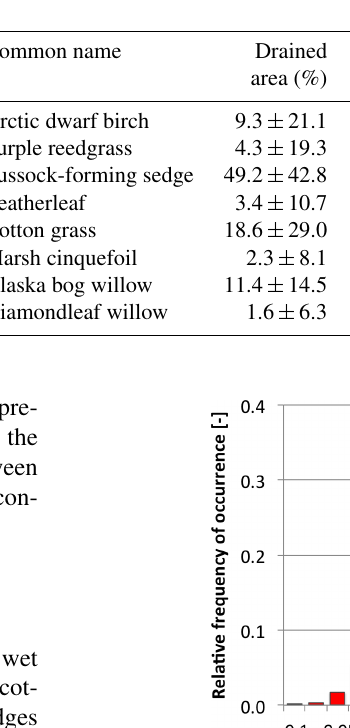
Table 1. Relative abundance of the major vascular plant species found within both disturbance regimes in the context of a non-destructive sampling campaign in 2014. The statistics exclude mosses, dead plants, and bare soil, as well as other plant species with a coverage fraction much smaller than 1%.